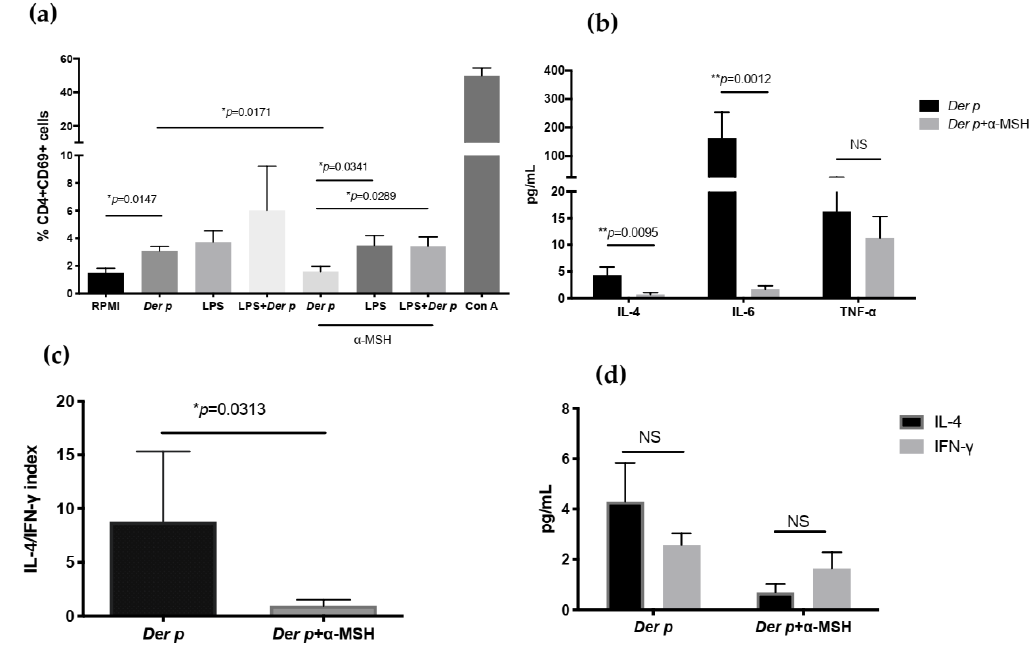
Figure 4. Expression of CD69 in CD4 + T cells and decreases in IL-4 and IL-6 after Der p stimulation. ( a ) CD69 expression in CD4 + T cells after 72 h of culturing with Der p , LPS, and α -MSH; ( b ) IL-4, IL-6, and TNF- α in supernatant after 72 h of culturing with Der p , LPS, and α -MSH; ( c ) IL-4 / IFN- γ index; ( d ) IL-4 and IFN- γ comparison after culturing with Der p and α -MSH. * p ≤ 0.05; ** p ≤ 0.01; NS p ≥ 0.05. 2.5. Increased Concentration of α -MSH in the Tears of Patients with Allergic